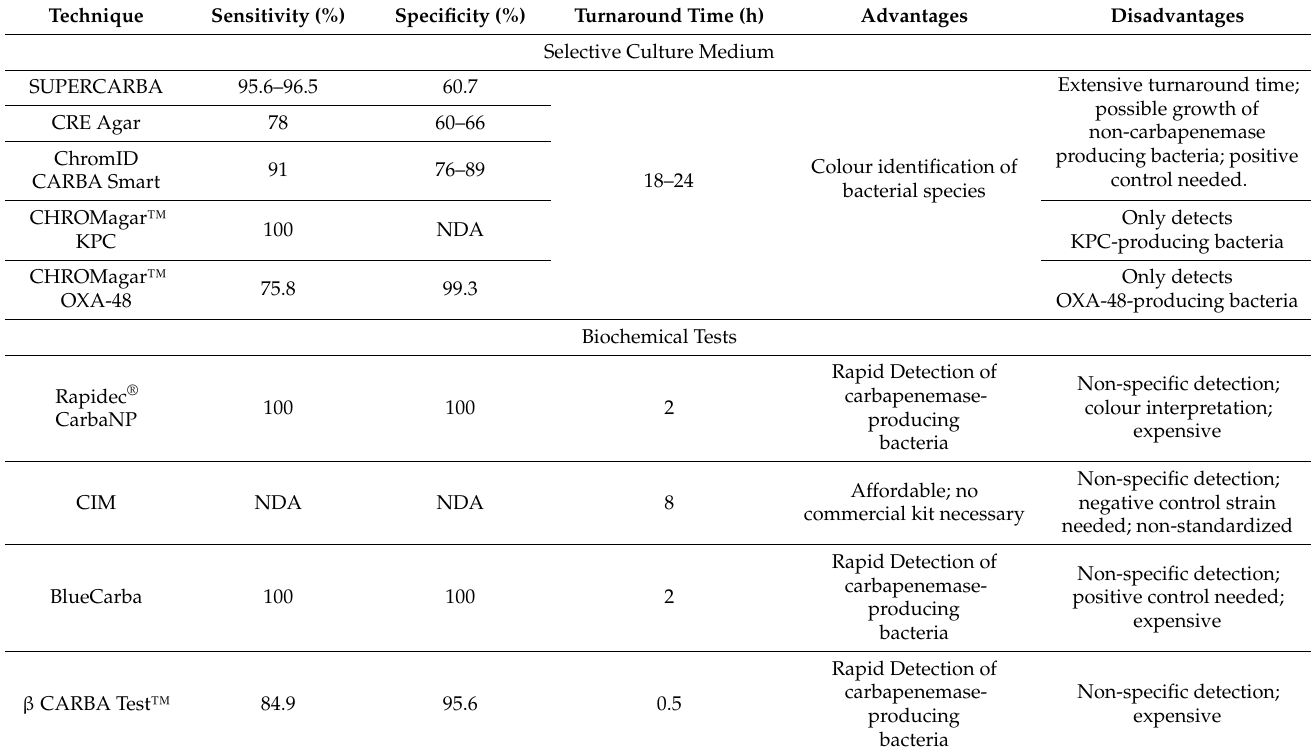
Table 3. Characteristics of selective culture media and biochemical tests for detection of carbapenemase- producing